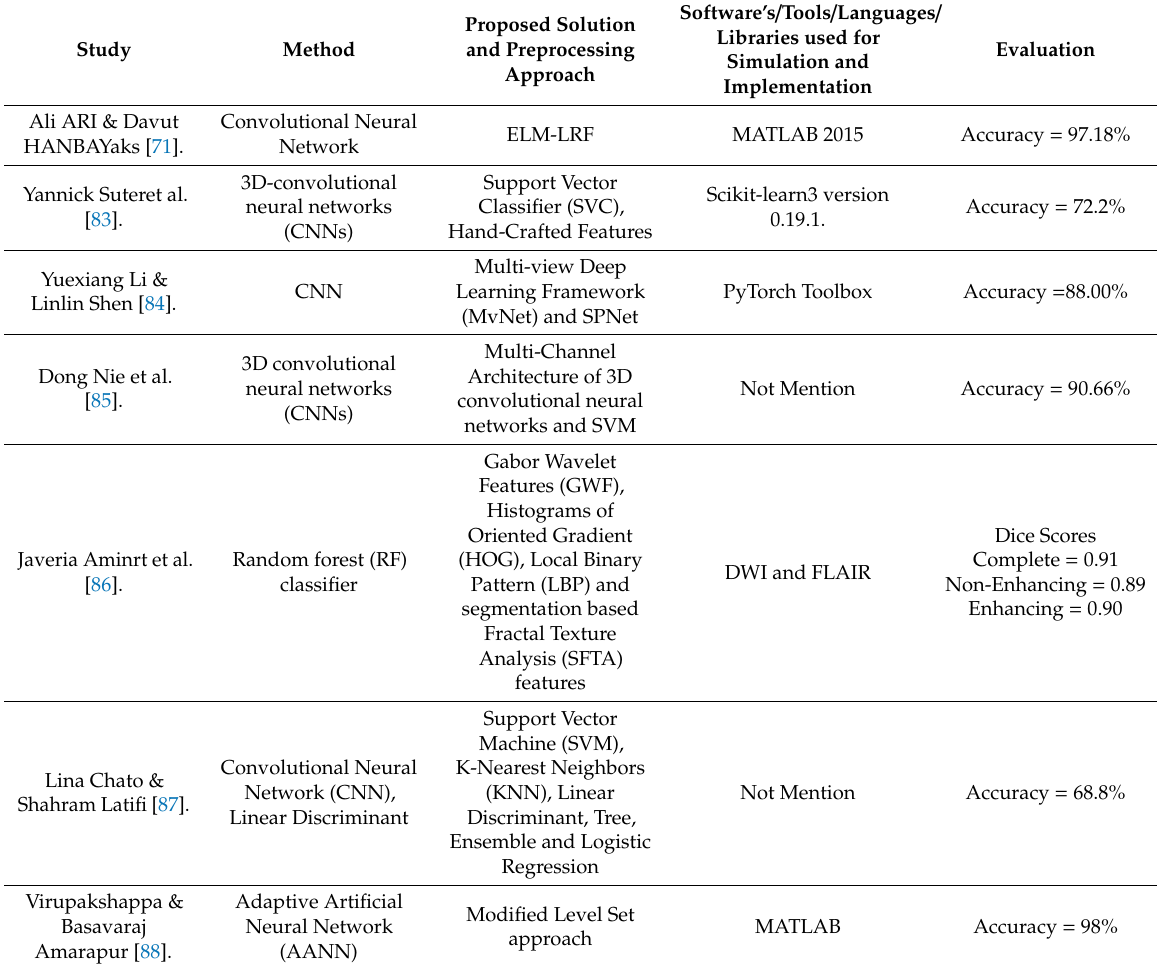
Table 3. Overview of papers using deep learning for brain tumor